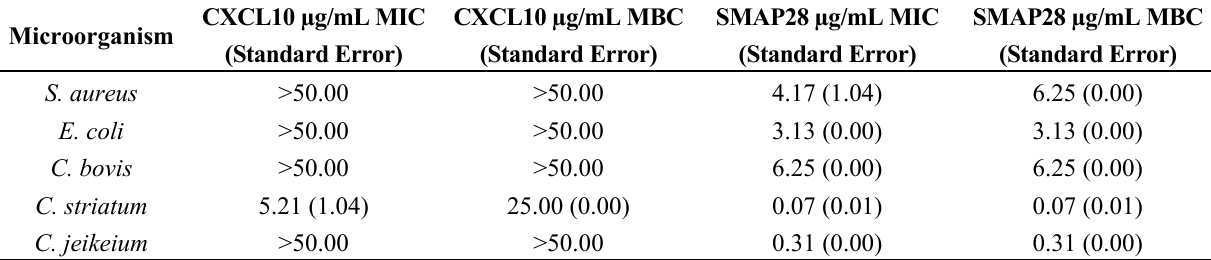
Table 1. Broth microdilution assays showing the minimal inhibitory concentration (MIC) and the minimal bactericidal concentration (MBC) of CXCL10 for microorganisms commonly found as commensals or pathogens on the skin.